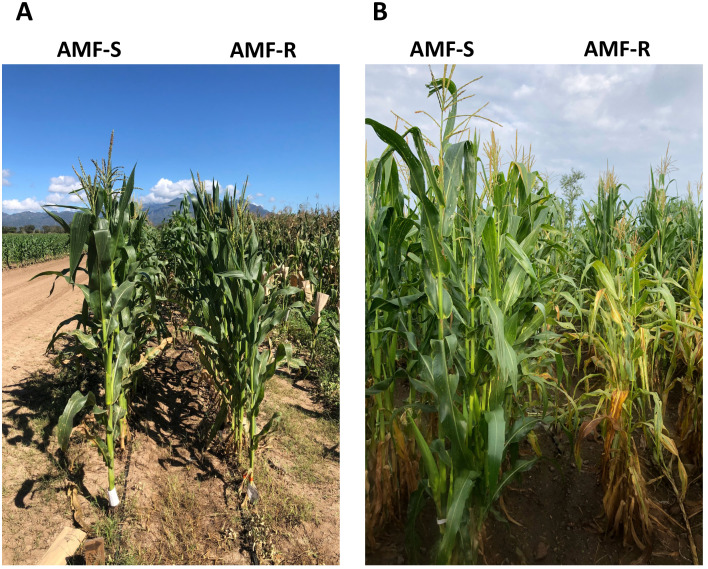
Representative AMF-S and AMF-R families in high- and medium- input sites.(A) Winter PV field in 2020, located in Nayarit, Mexico. (B) Summer Ameca field in 2019, located in Jalisco, Mexico.